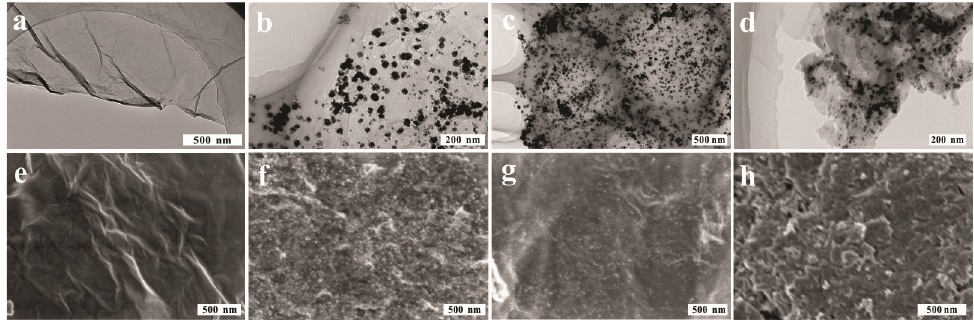
Figure 2. TEM and SEM images of ( a , e ) GO, ( b , f ) GO–PtCo, ( c , g ) GO–PtCo@MIPDA, and ( d , h ) GO–PtCo@NIPDA.